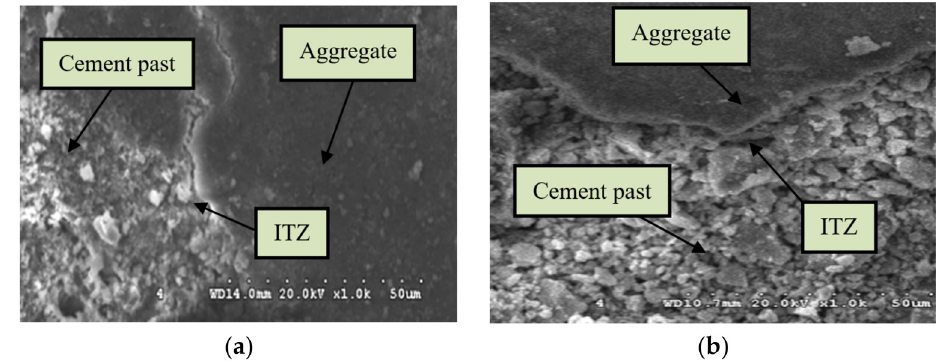
Figure 16. Microstructure of ITZ between aggregate and cement paste: ( a ) R0-H0; ( b ) R100-H0.